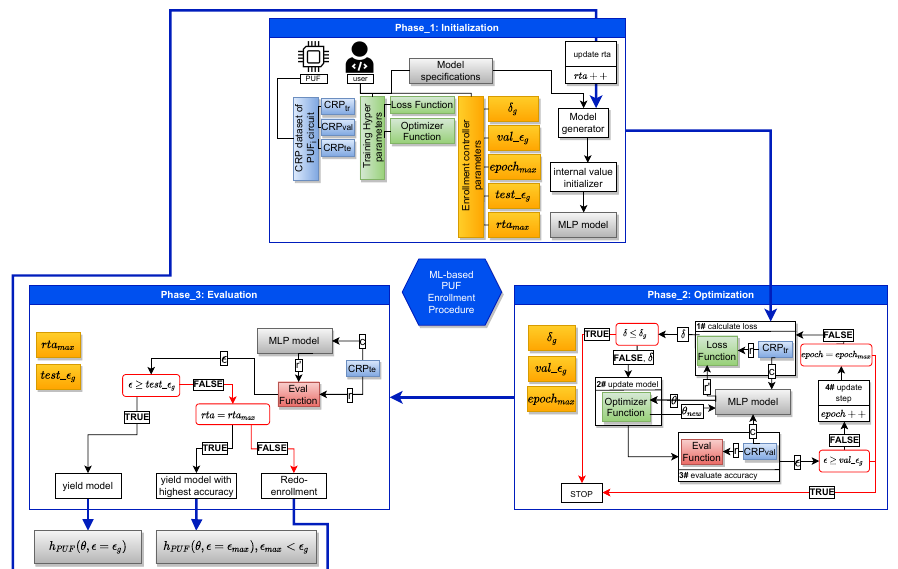
Figure 3. Our proposed ML-based enrollment